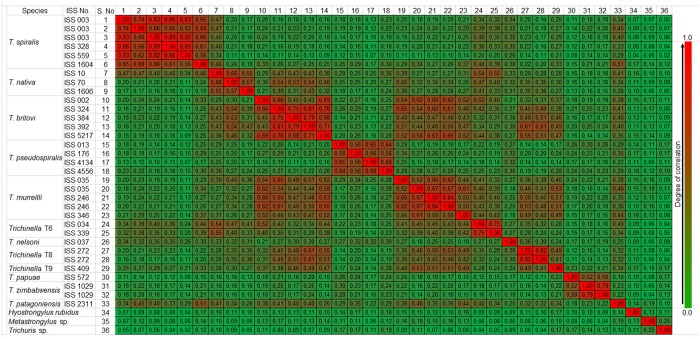
Composite correlation index analysis.Changes in color from red to blue correspond to decreasing degrees of correlation.